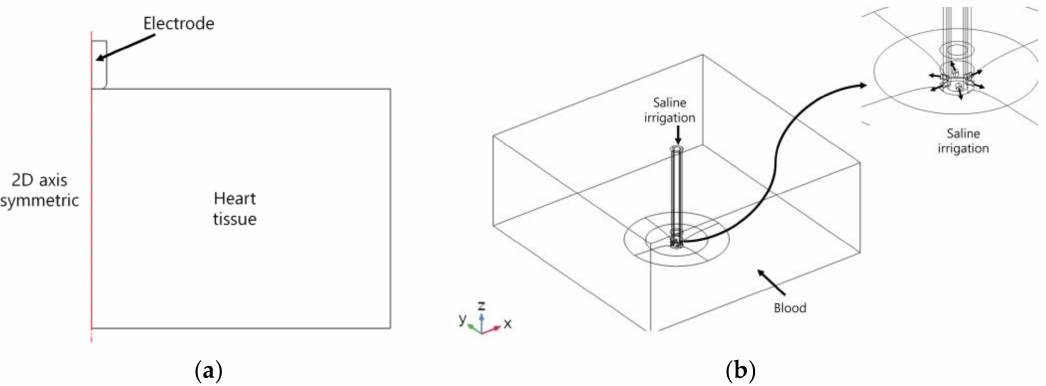
Figure 2. Definition of the deformation model of heart tissue ( a ) and the mixing model between saline and blood flow ( b